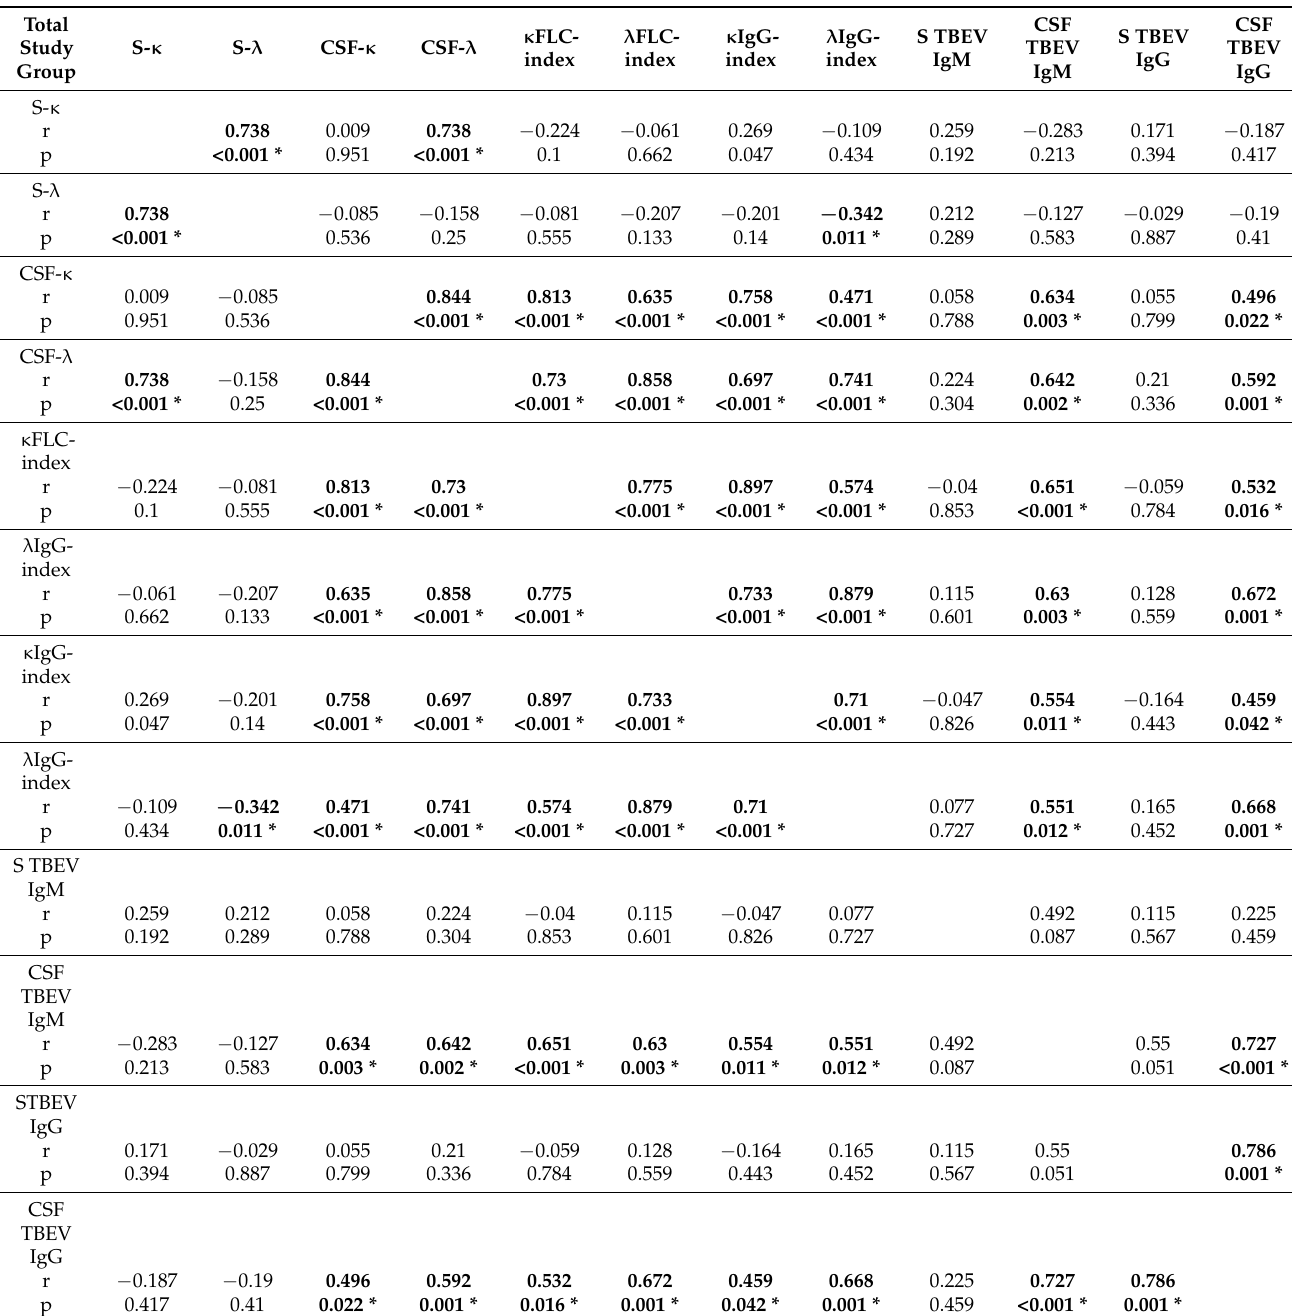
Table 4. The Spearman’s correlations between tested variables in the total study